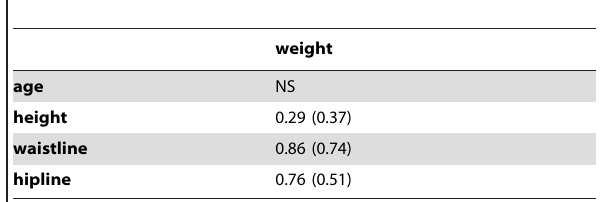
Table 2. Pearson partial correlation coefficients of anthropometric variables and weight for the full DXA data set (IG + CV=341 patients).